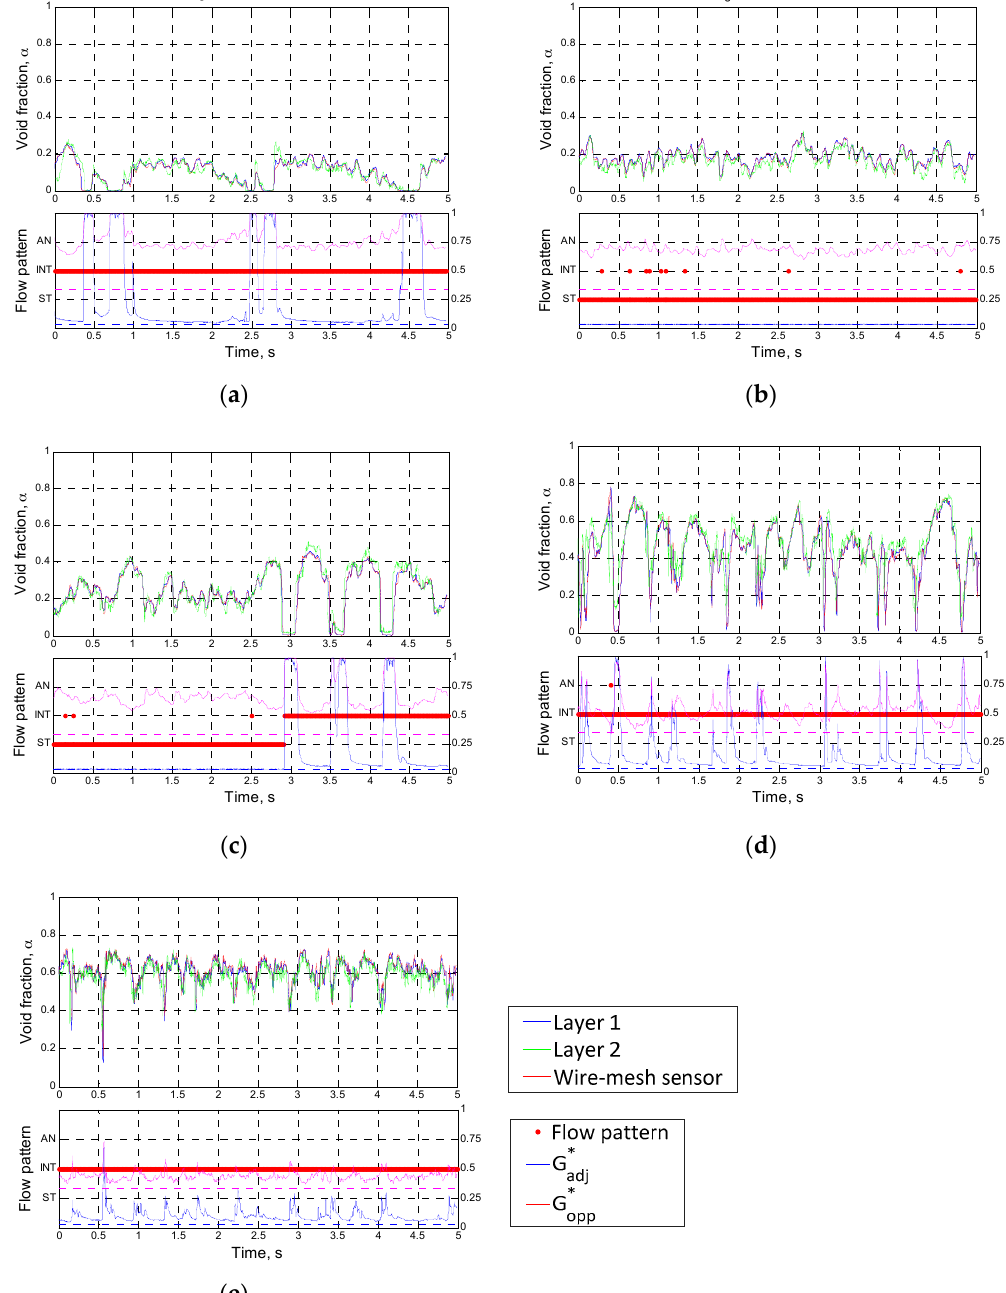
Figure 13. The results of the flow pattern classification and the corresponding time series of the void fraction with varying the gas superficial velocity (Note: The right Y -axis of the lower graphs indicates the dimensionless conductance). ( a ) Case 6: j l = 2.0 m/s, j g = 0.1 m/s, j sv = 2.04 m/s. ( b ) Case 7: j l = 2.0 m/s, j g = 0.5 m/s, j sv = 2.29 m/s. ( c ) Case 8: j l = 2.0 m/s, j g = 1.0 m/s, j sv = 2.49 m/s. ( d ) Case 9: j l = 2.0 m/s, j g = 5.0 m/s, j sv = 4.05 m/s. ( e ) Case 10: j l = 2.0 m/s, j g = 12 m/s, j sv = 4.91 m/s.